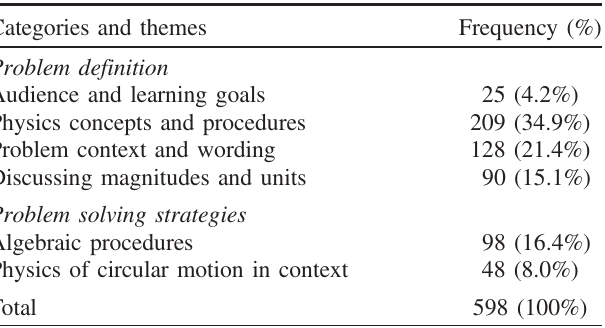
TABLE III. Categories and themes addressed by 4 participants groups during the task of generating a physics problem for high school students, and number of times (percentages) coded in the aggregated